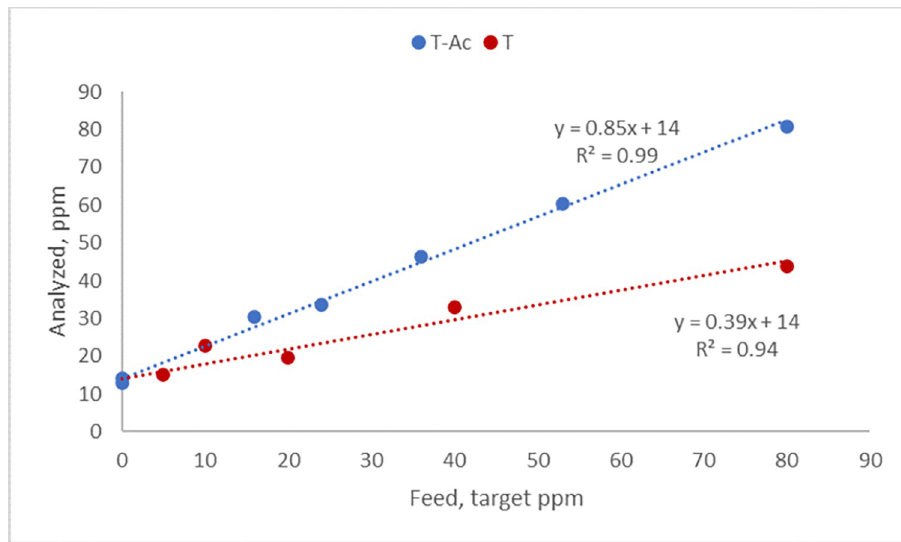
Fig 1. Analyzed vs. formulated vitamin E levels in the experimental